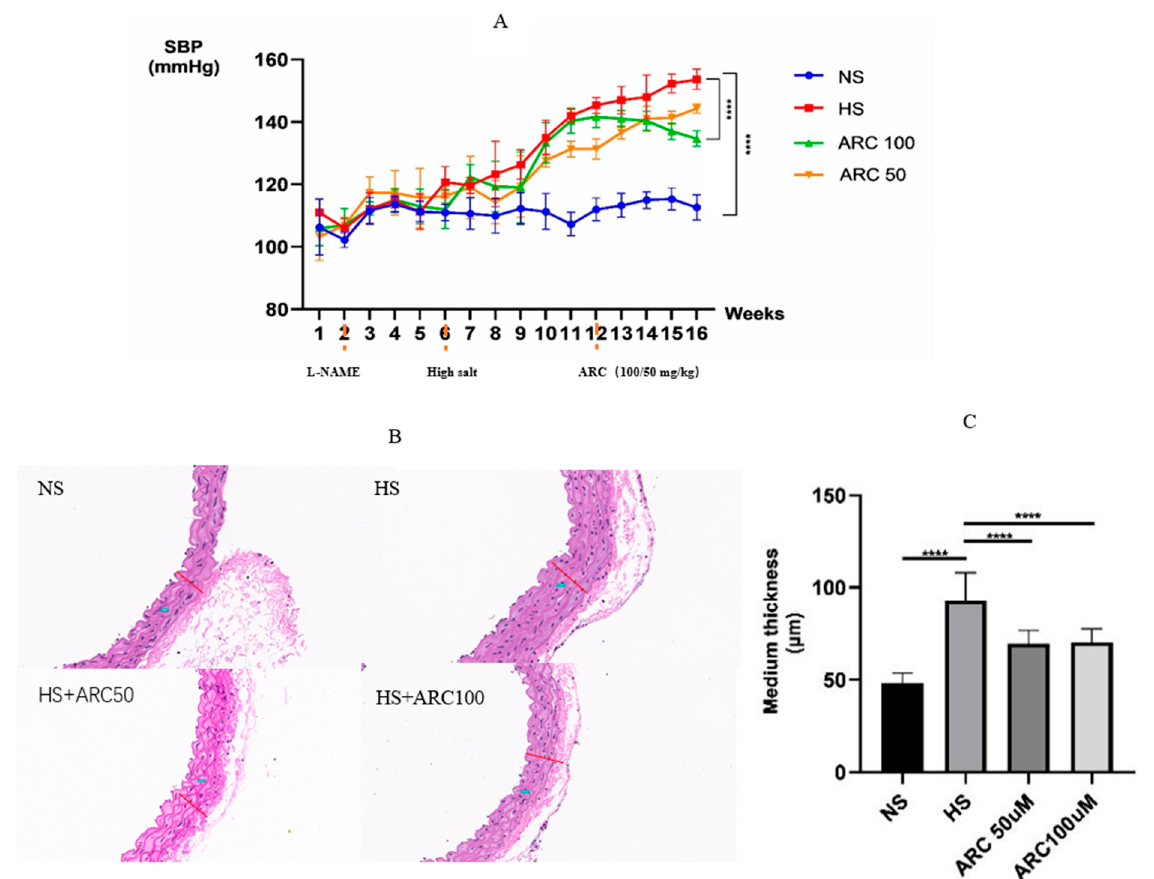
Figure 2. ( A ) SBP in different groups from the first week to the 16th week. Mice in the HS, HS+ARC50, and HS+ARC100 groups received L-NAME in the second week for 2 weeks and were fed with high-salt water from the sixth week. Mice received ARC treatment for 4 weeks after L-NAME/high-salt diet. SBP between NS and HS, HS and HS+ARC100 groups showed significant difference using one-way ANOVA and p -value adjusted for multiple comparisons with Sidak multiple-comparison test ( n = 4), **** p < 0.0001. ( B ) Aortic intima-media thickness in different groups, ( C ) Quantitative analysis of aortic intima-media thickness in every group, showing the significant difference between NS and HS groups, HS group and ARC 50/ARC 100 groups using one-way ANOVA and P-value adjusted for multiple comparisons with Sidak multiple-comparison test ( n = 4), **** p < 0.0001. NS: normal salt diet group, HS: L-NAME/high-salt group, HS+ARC50: L-NAME/high salt + arctigenin (50 mg/kg) group, HS+ARC100: L ‐ NAME/high salt + arctigenin (100 mg/kg) group.